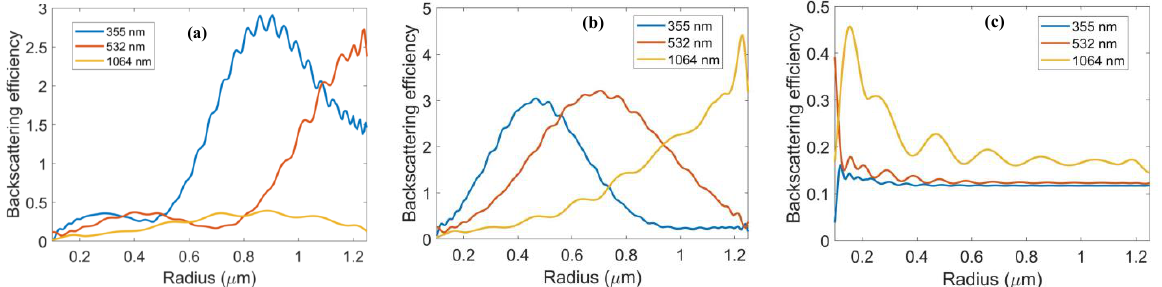
Figure 4. Back scattering intensity from ( a ) pure water, ( b ) contaminated water and ( c ) black carbon as a function of the size of the scatterer for different incident laser wavelengths.